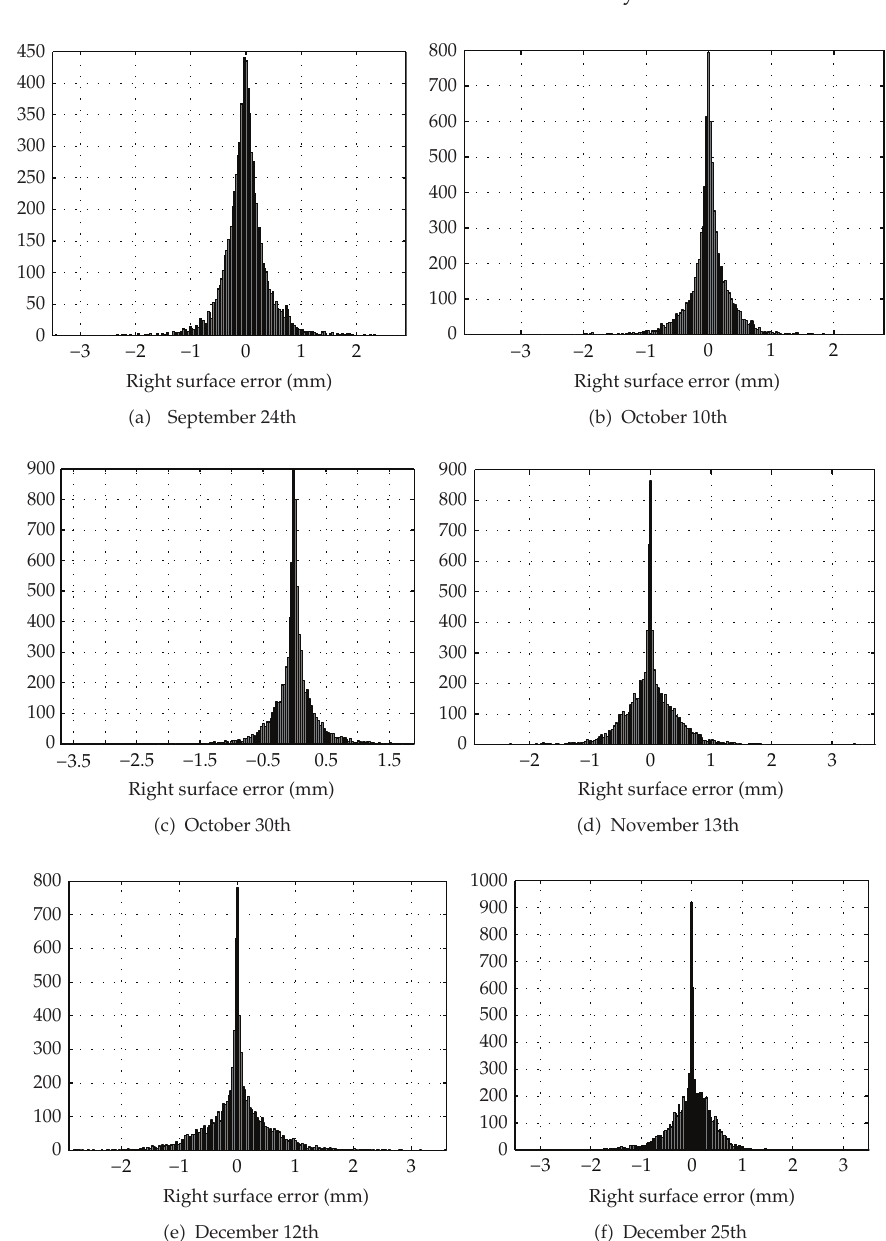
Figure 5: Histograms on errors in right surface predictions of all sampling points in Jiulong-Beijing track section from K612 (cid:8) 000 to K614 (cid:8)